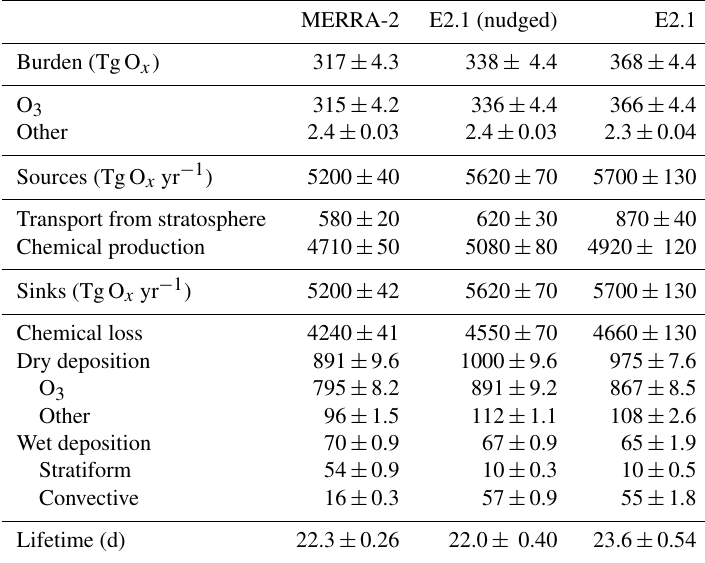
Table 9. Tropospheric odd-oxygen (O x ) ∗ family budget for